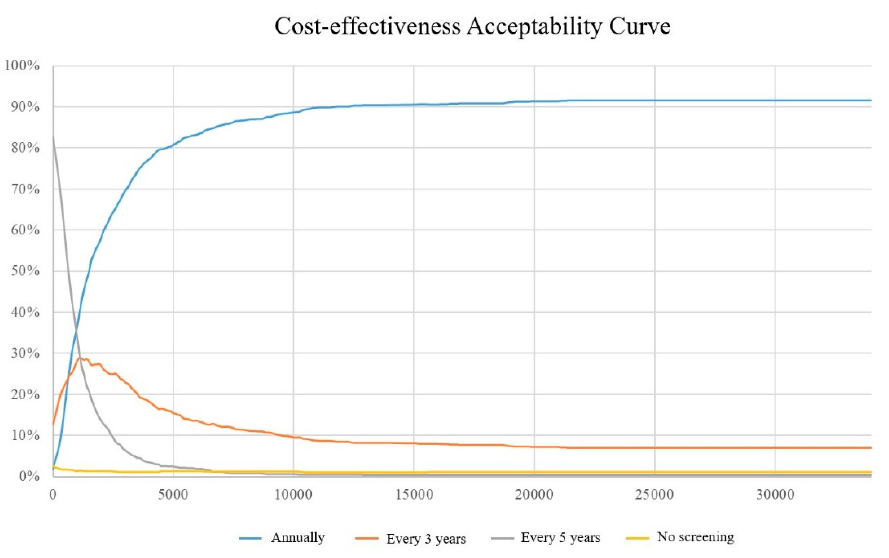
Figure 3. Cost-Effectiveness acceptability curve. Figure 4A,B show CE plane of PSA results based on 1000 Monte Carlo simulations.